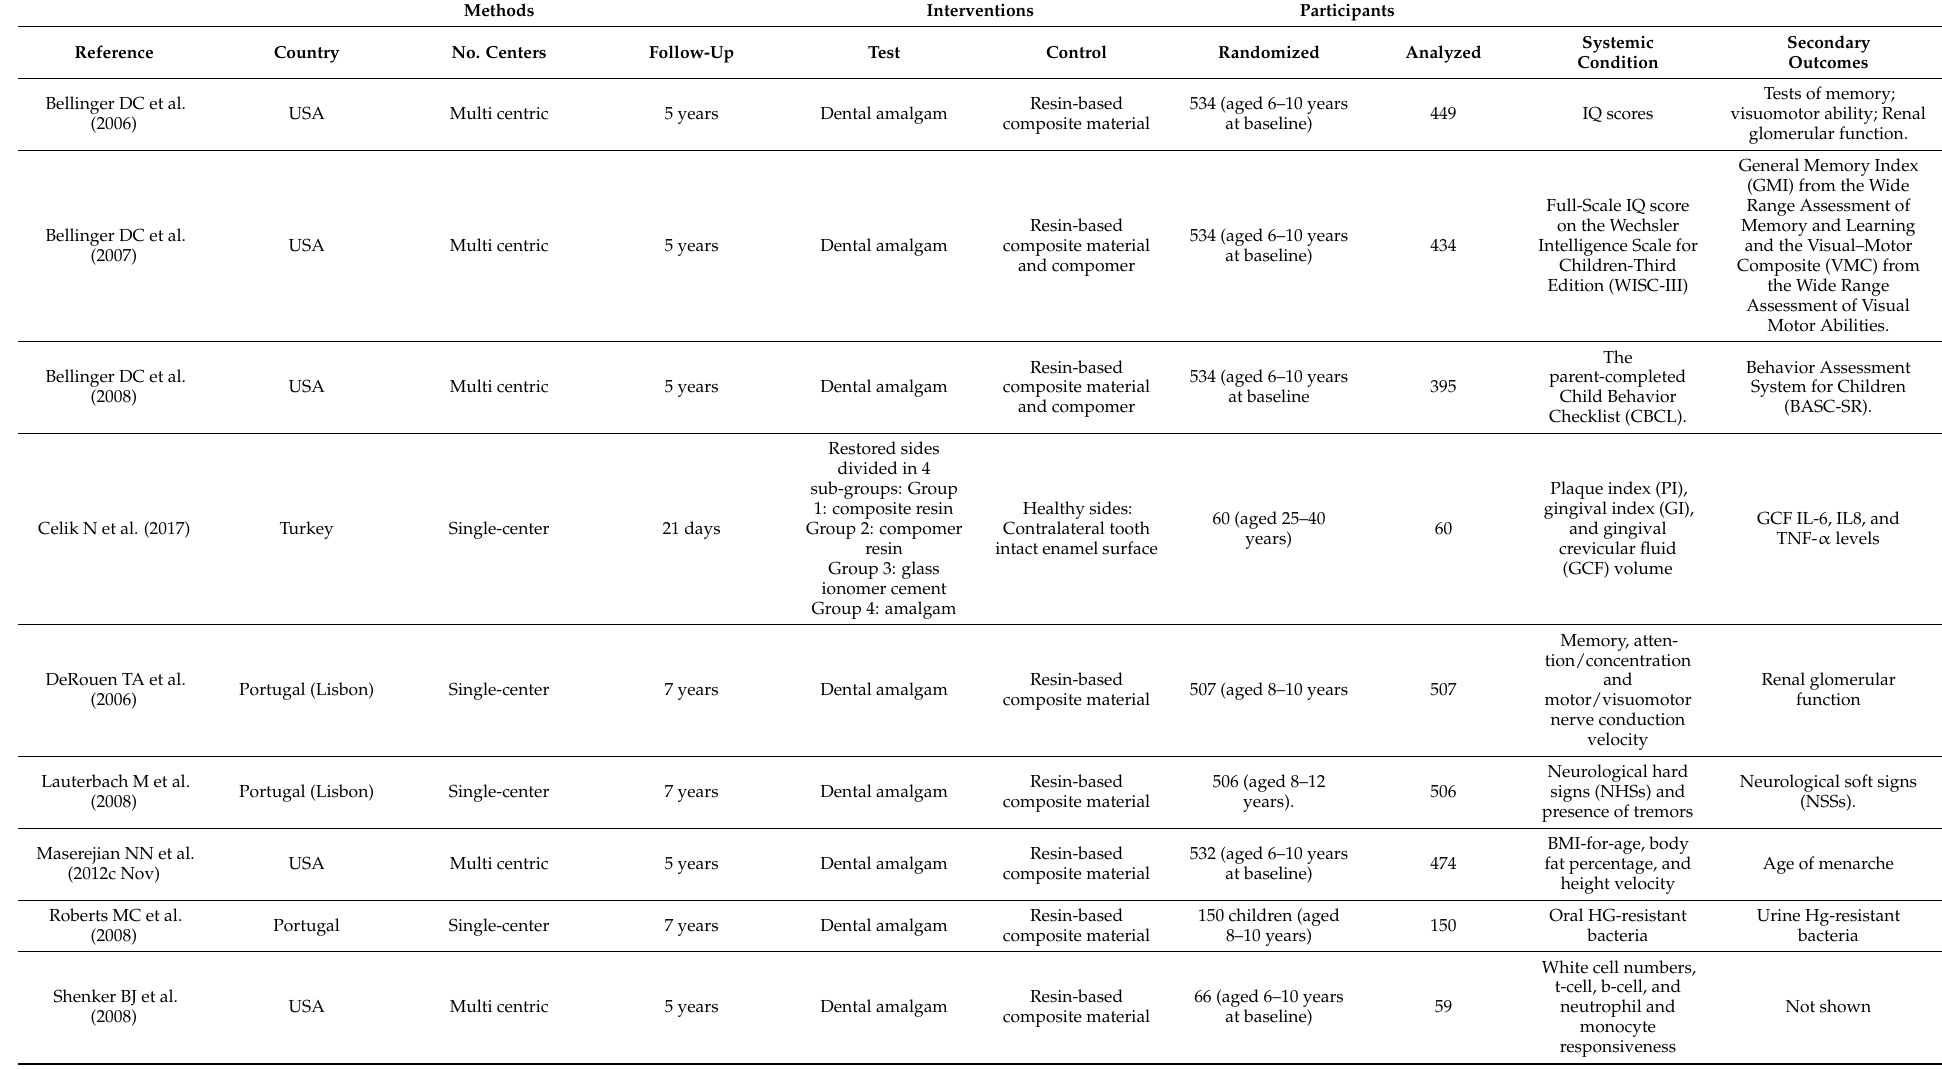
Table 1. General overview of the included